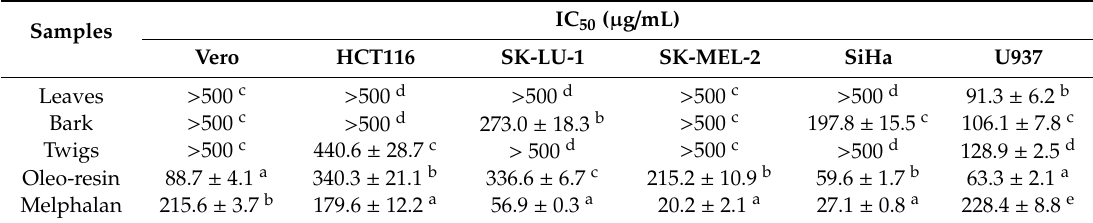
Table 3. Cytotoxic activity of D. alatus extracts against several cancer cells.